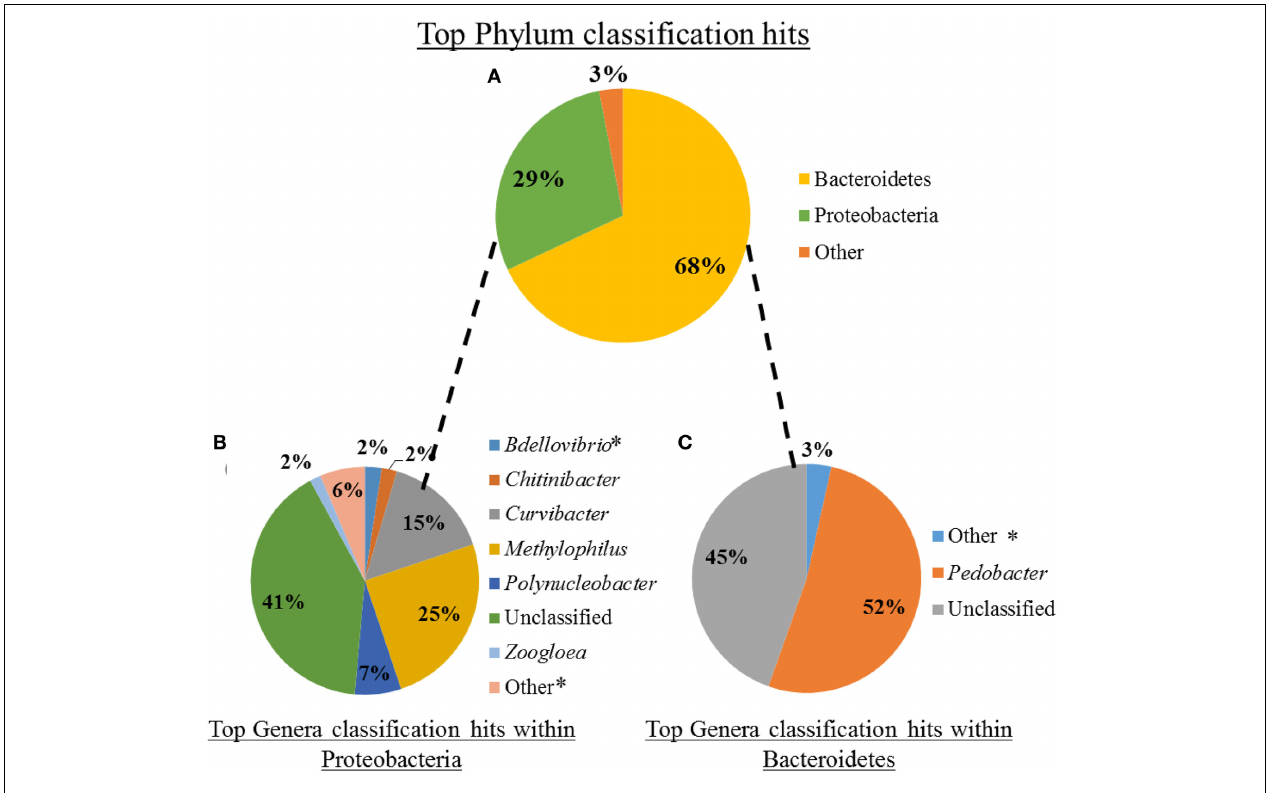
FIGURE 2 | Microbiota composition of shed leech mucus obtained through Illumina sequencing of the V3-V4 hypervariable region of 16S rRNA gene. (A) The relative abundance of total reads, following quality control, within phyla. (B) The relative abundance of reads, comprising ≥ 2%